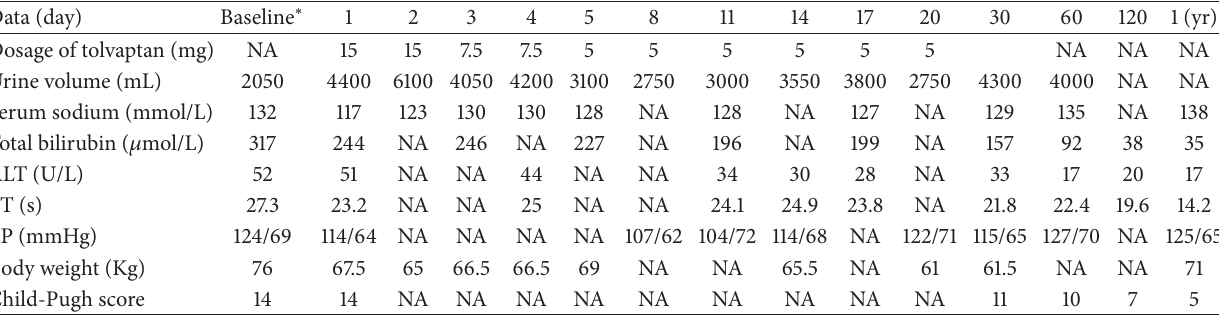
Table 1: Serum sodium concentrations and urine volumes of the present patient under the treatment of different doses of tolvaptan. Data